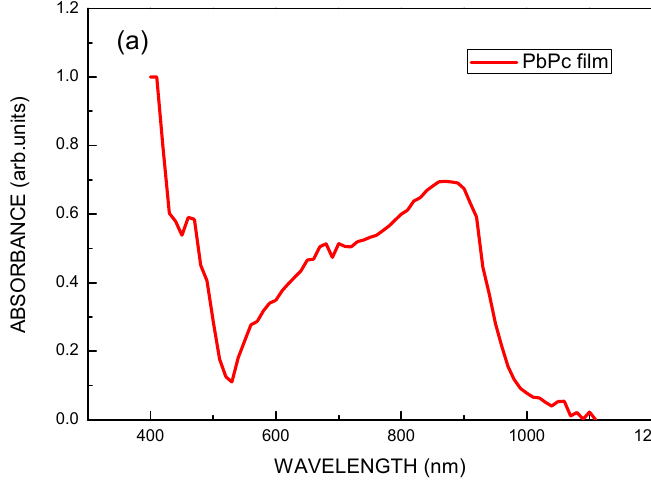
Figure 6. ( a ) Absorbance of PbPc film. ( b ) The relationship between the annealing temperature and the resistivity and mobility of